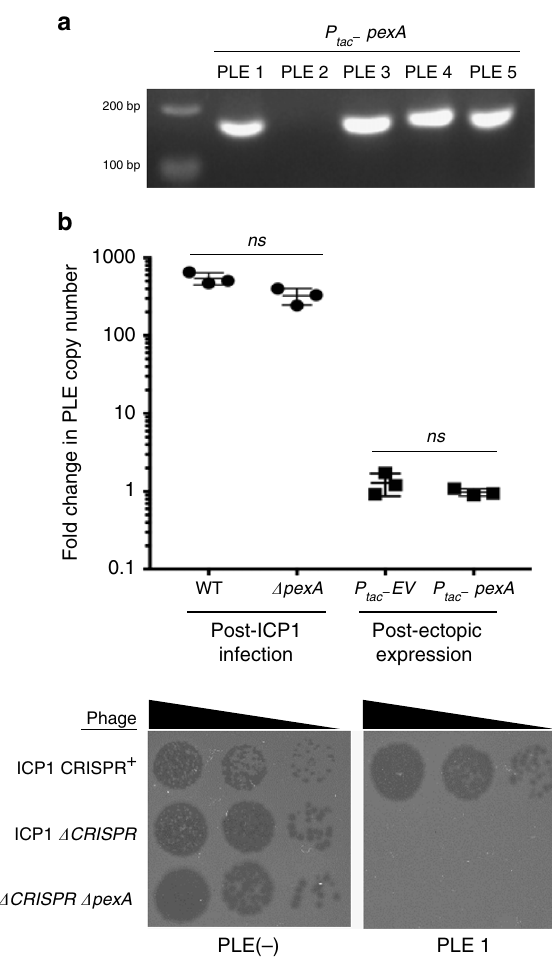
Fig. 5 PexA directs historic PLEs to circularize and is dispensable for PLE 1 anti-phage activity. a Circularization PCR of all PLEs probed during ectopic expression of PexA. b Fold change in PLE 1 copy number as measured by qPCR. Left, PLE copy number was compared before and 20 min after ICP1 2004 or ICP1 2004 Δ pexA infection. Right, PLE copy number was examined before and 15 min following ectopic expression of an empty vector (EV) or pexA . Bars represent the mean and standard deviation of three independent replicates tested ( ns , not signi fi cant by T Test). c Tenfold dilutions of ICP1 spotted on V. cholerae PLE − or PLE 1 lawns showing the ability of different phage strains to form plaques (dark spots, zones of killing). ICP1 and ICP1 Δ pexA are unable to form plaques on PLE 1, while the CRISPR pro fi cient phage is able to overcome PLE 1 and form plaques 18